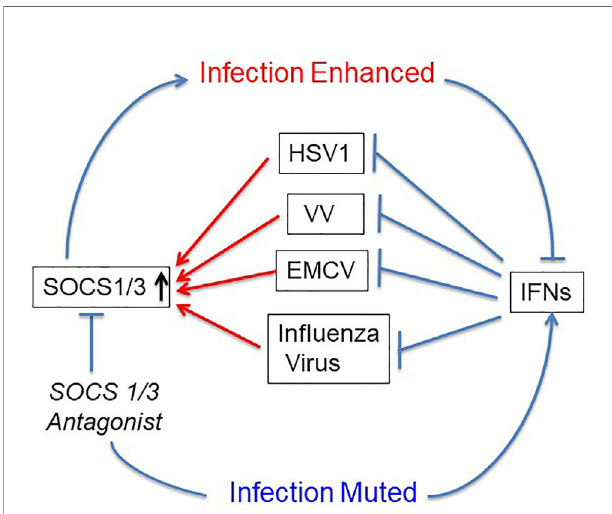
FIGURE 2 | SOCS1/3 blocks IFN activity. Viruses with different mechanisms of replication have been shown to upregulate or use constitutive SOCS1/3 as virulence factors. SOCS1/3 antagonist peptide blocks the SOCS, thus freeing the interferons (IFNs) to inhibit virus replication. HSV-1, herpes simplex virus 1; VV, vaccinia virus; EMCV, encephalomyocarditis